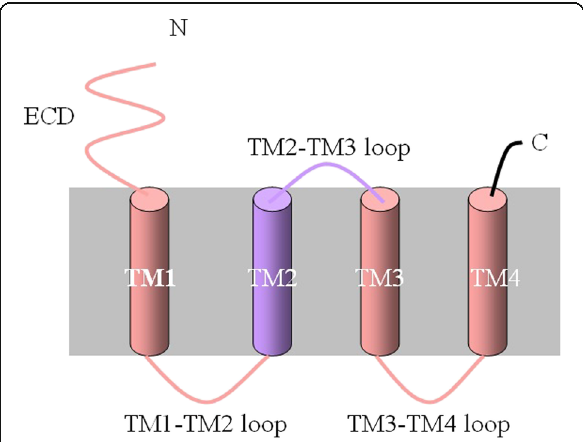
Fig. 2 The schematic diagram shows the spanning domains (TM1- TM4) topology of GlyR α 1 subunit. Mutations in the ECD, TM1, TM1- TM2 loop, TM3, TM3-TM4 loop and TM4 are more often recessive and part of a compound mutation, while those in TM2 and the TM2-TM3 loop are more likely to be dominant hereditary